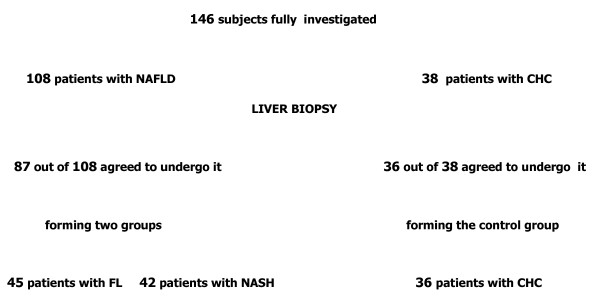
The flow of participants through the study. NAFLD, non-alcoholic fatty liver disease; FL, fatty liver; NASH, non-alcoholic steatohepatitis; CHC, chronic hepatitis C.